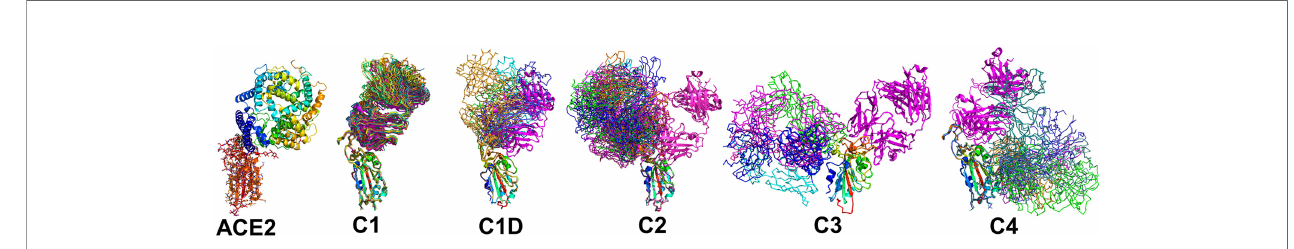
FIGURE 4 | Epitope conservation and diversity within each NAb class. The RBD-ACE2 interaction, as well as all members of each NAb class are shown on the RBD. A ribbon diagram of an archetypical C1 NAb (magenta) is shown in each fi gure as a